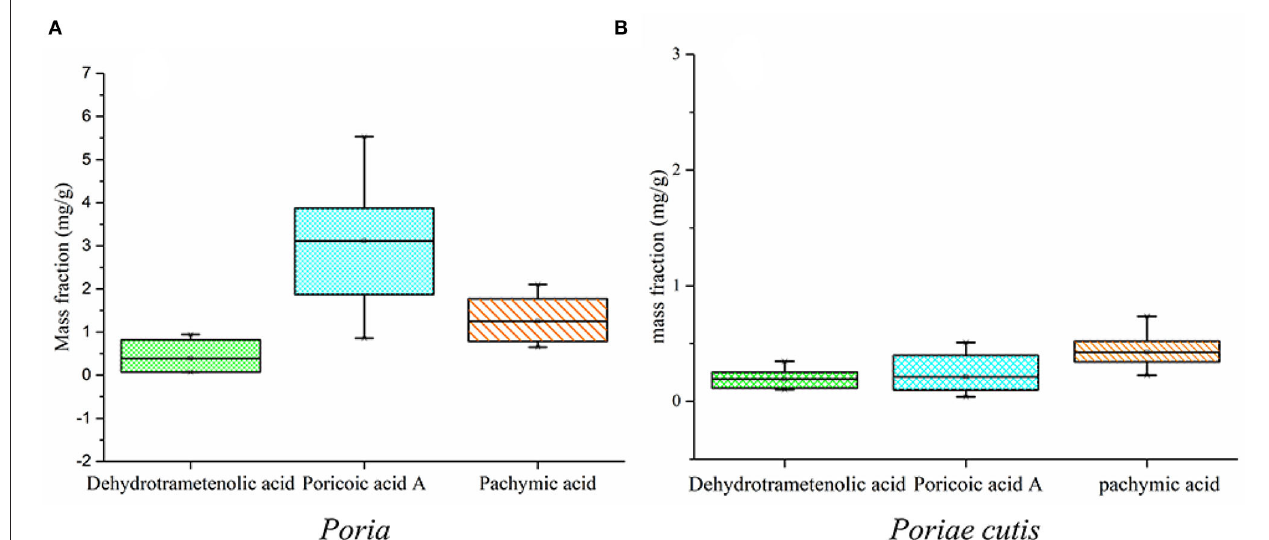
FIGURE 8 | A box plot of dehydrotrametenolic acid, poricoic acid A, and pachymic acid content (%). (A) Poria ; (B) Poriae